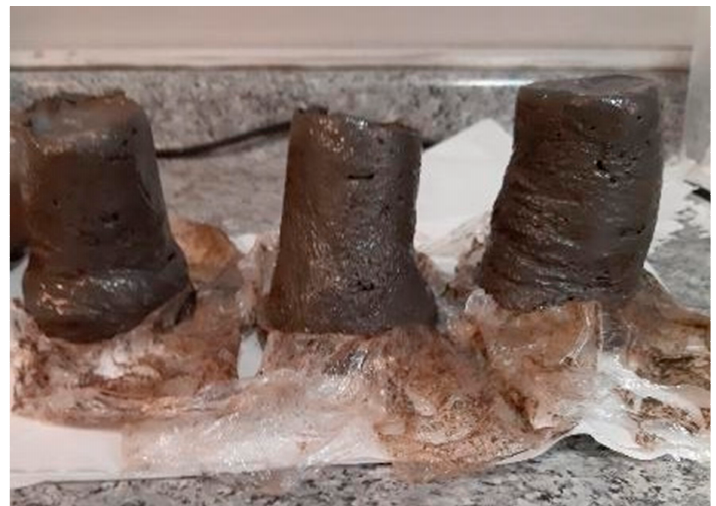
Figure 18. Consistency of Method VII, cured at 60 °C for 24 h.